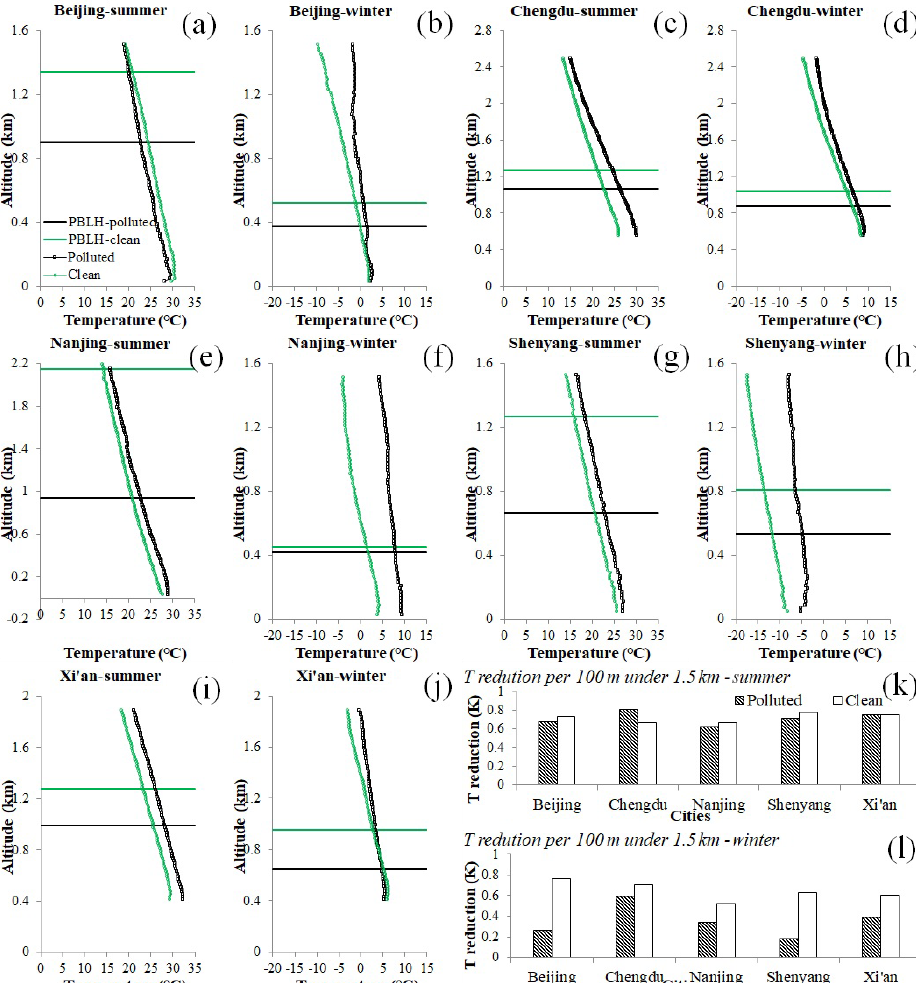
Figure 9. Mean vertical temperature profiles (vertical curves; unit: ◦ C) at five cities in different seasons under polluted (black) and clean (green) conditions. Mean PBL heights under polluted and clean conditions are also shown (black and green horizontal lines, respectively). Panels (a) , (c) , (e) , (g) , and (i) show summertime results, and panels (d) , (f) , (h) , and (j) show wintertime results. Panels (k) and (l) show temperature reductions below 1.5km (unit: K(100m) − 1 ) under polluted (hatched bars) and clean (white bars) conditions in summer and winter,